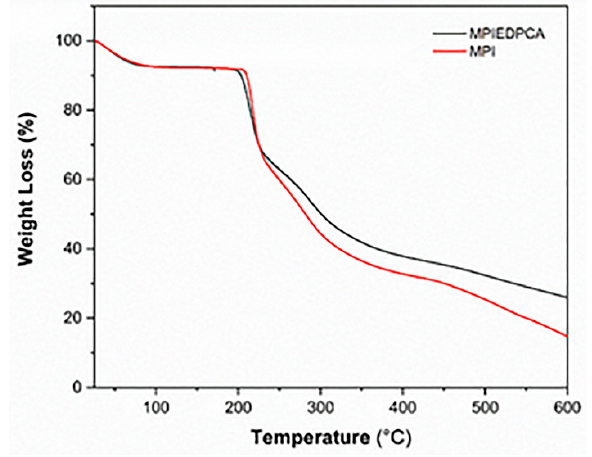
Figure 7. TGA thermograms of MPI and the conjugate MPIEDPCA.